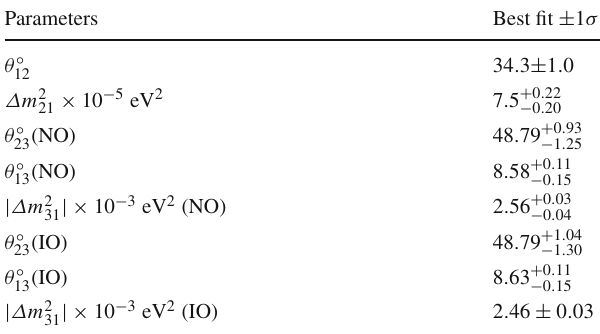
Table 2 Standard neutrino oscillation parameters with 1 σ intervals obtained in [57] Parameters